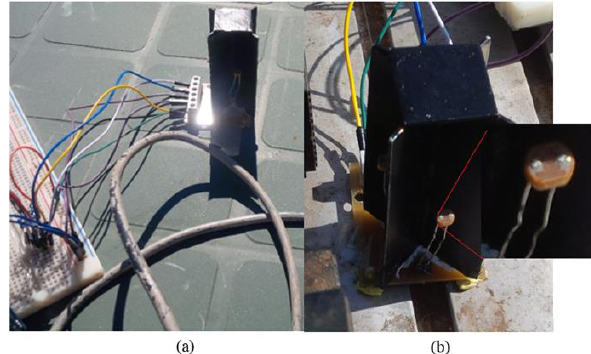
Figure 12. Second experimental set up (solar